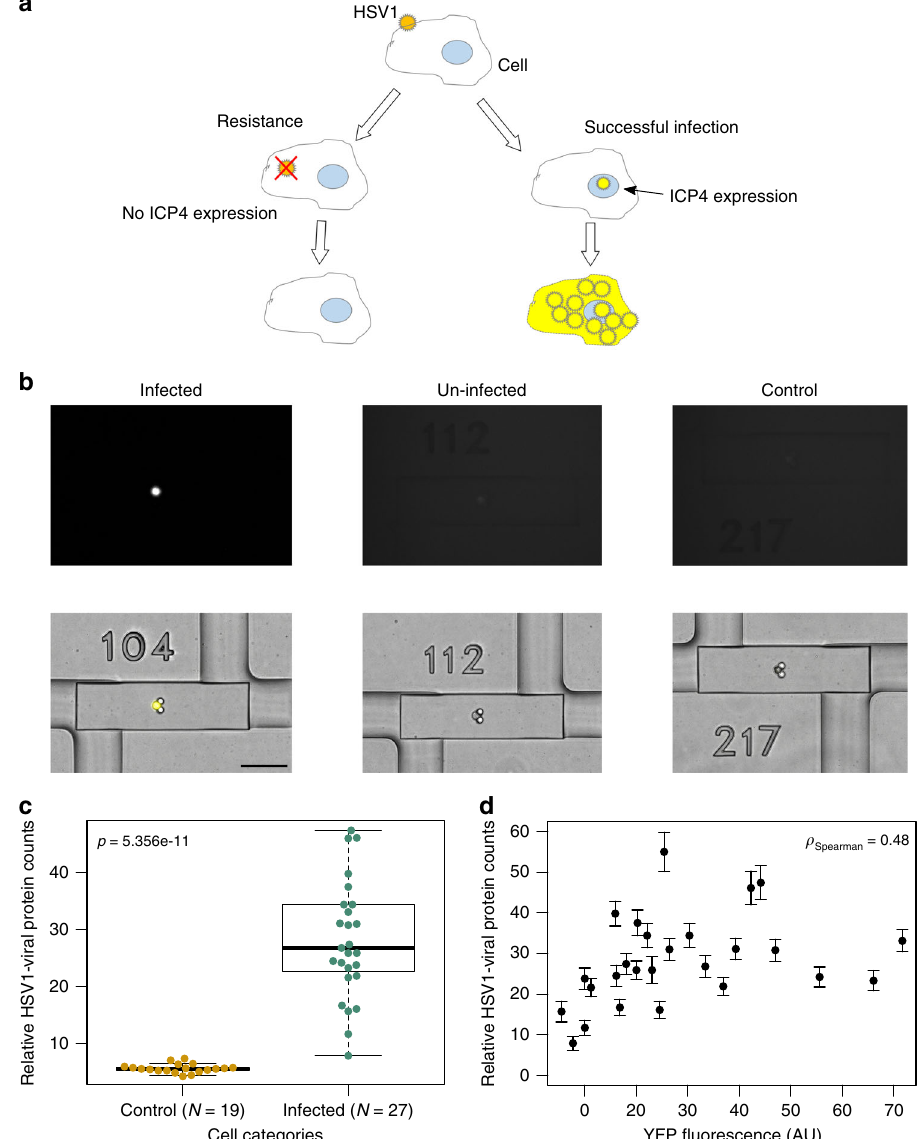
Fig. 4 Joint live-cell imaging and digital protein analysis of HSV-1 virus infected human lung epithelial cells (A549) cells. a Schematic of viral infection process: if infection succeeded, viral genome goes into host cell nucleus and ICP4-YFP is expressed and viral proteins are produced; if the cell is resistant to viral infection, ICP4-YFP viral proteins will not be produced. b Images of ICP4-YFP (top), superimposed bright fi eld (BF) and YFP (bottom) for infected, un- infected, and control single cells (scale bar: 100 µ m). c Comparison of HSV-1 viral proteins counts in control cells ( N = 19) and infected cells ( N = 27) showed signi fi cant differences between two groups. P value was calculated using two-sided Welch ’ s t test. The center thick line of the box plot indicates the median of the data, the two hinges of the box represents the fi rst and third quartile, and the whiskers indicate the full data range. d Correlation of the relative HSV-1 viral protein counts (micro fl uidic-digital proximity ligation assay ( µ -dPLA) readout) with YFP fl uorescence level has a Spearman ’ s coef fi